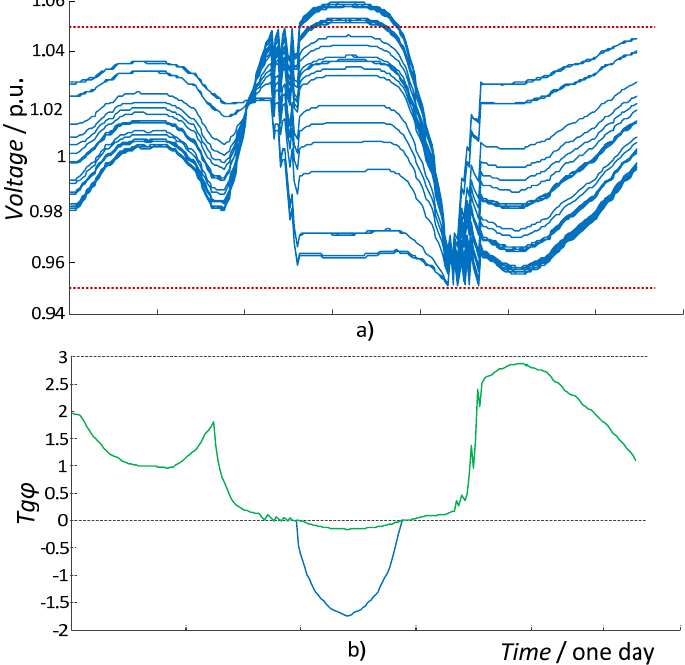
Figure 16. Different types of voltage control to mitigate the voltage rise. ( a ) One-day voltage profile of all MV/LV substations measured at one feeder; ( b ) optimal tg φ for one feeder with respect to voltage limits for all the generators (green line). Generators have to contribute more reactive power during peak h if only a few of them at the end of the feeder are requested to contribute (blue